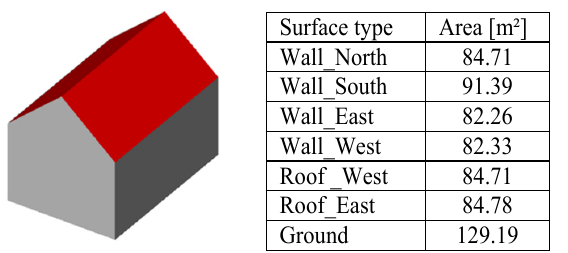
Figure 7. The CityGML building extracted for simulation in TRNSYS ( left ) and corresponding geometric properties ( right ).